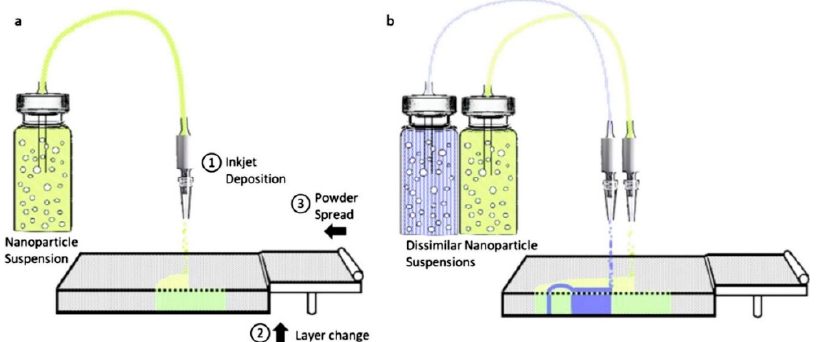
Figure 28. ( a ) The proposed BJ approach to fabricate nanocomposites; ( b ) switching between dis- similar nanoparticle inks produces multimaterial and functionally graded nanocomposites (adapted with permission from reference [69]).